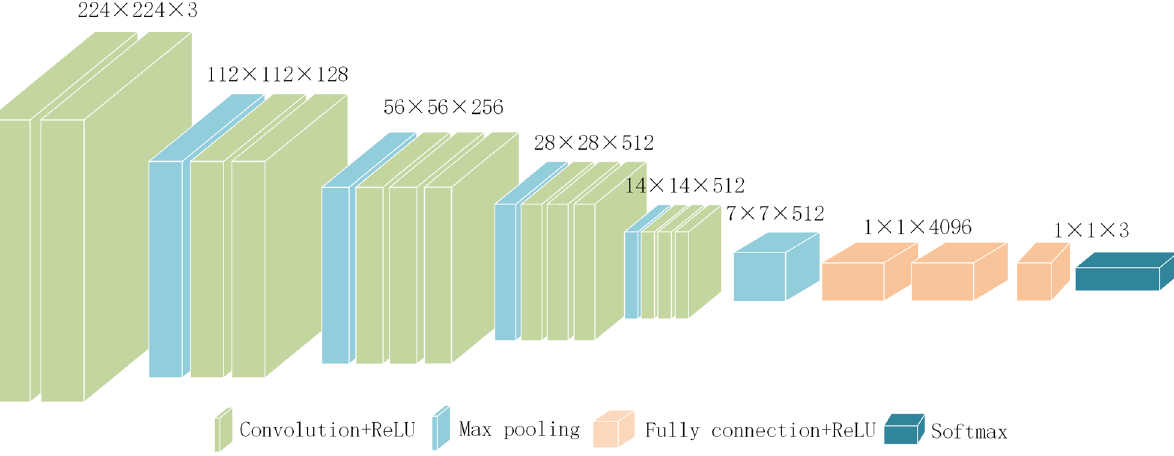
Figure 2. The structure of convolution network